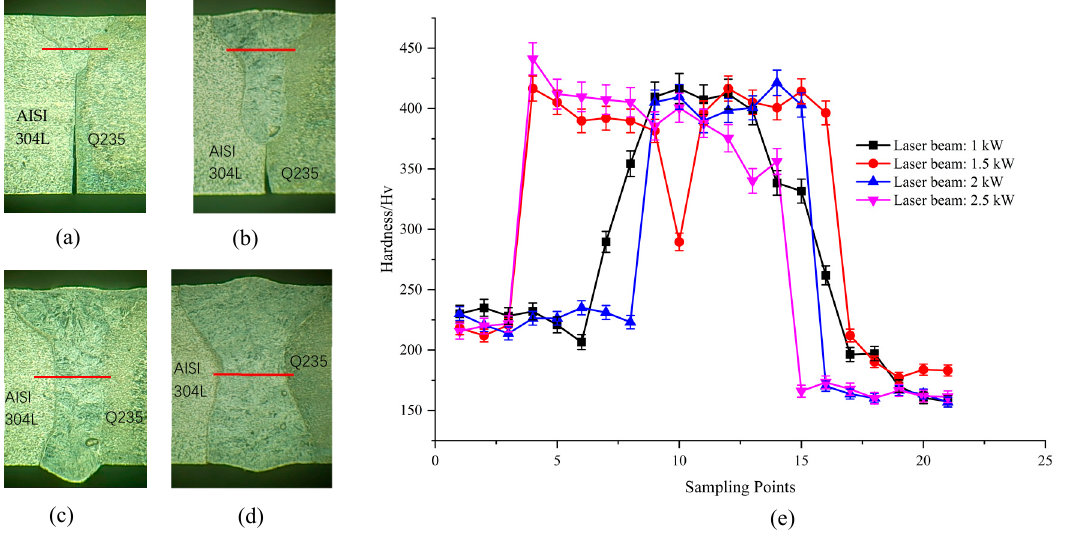
Figure 11. The cross-section views and hardness test results with different laser powers: ( a ) laser power = 1 kW; ( b ) laser power = 1.5 kW; ( c ) laser power = 2 kW; ( d ) laser power = 2.5 kW; ( e ) hardness test results.